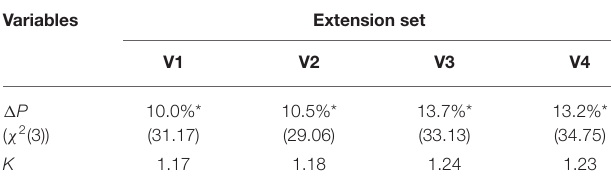
TABLE 7 | 1 P and K of decoy effect in the pork hindquarter